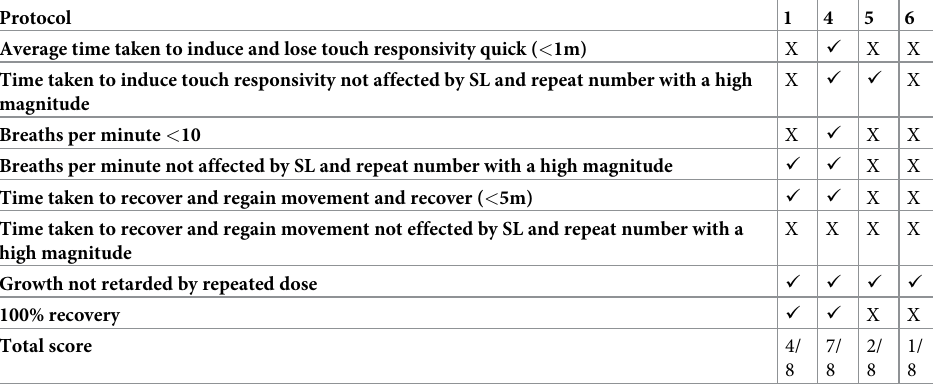
Table 6. Summary table of protocols and